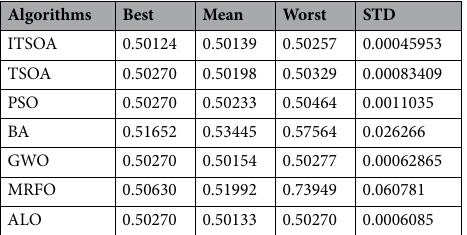
Table 6. Statistic Analysis of methods for multiobjective problem of 13-bus unbalanced network.